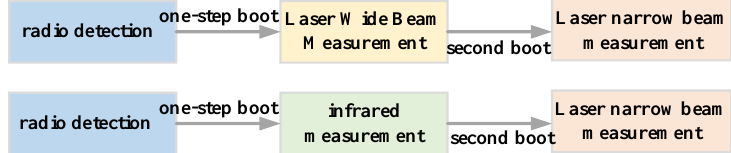
Figure 30. Flow chart of laser multiple guidance measurement.